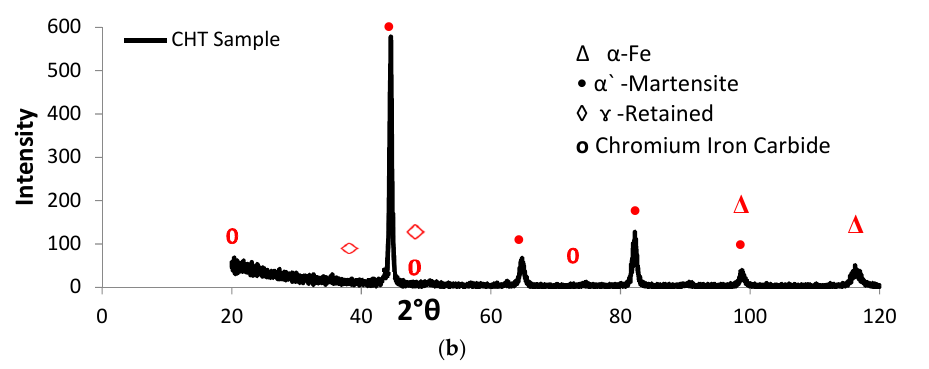
Figure 4. X ‐ ray diffraction pattern of ( a ) untreated AISI 416 and ( b ) conventionally heat treated (CHT) samples.